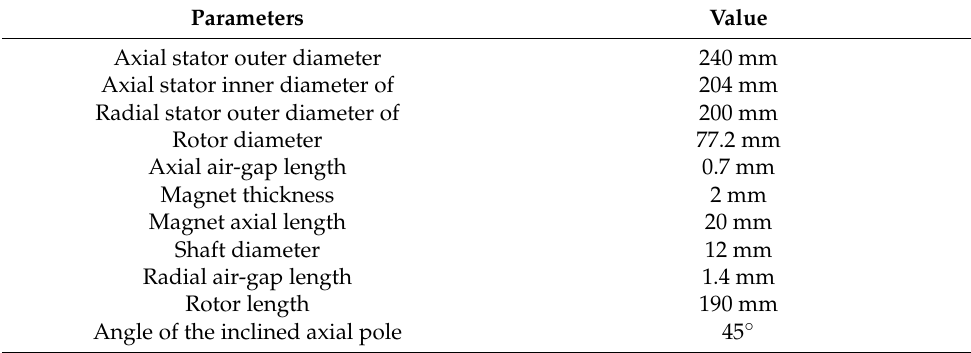
Table 1. Main design